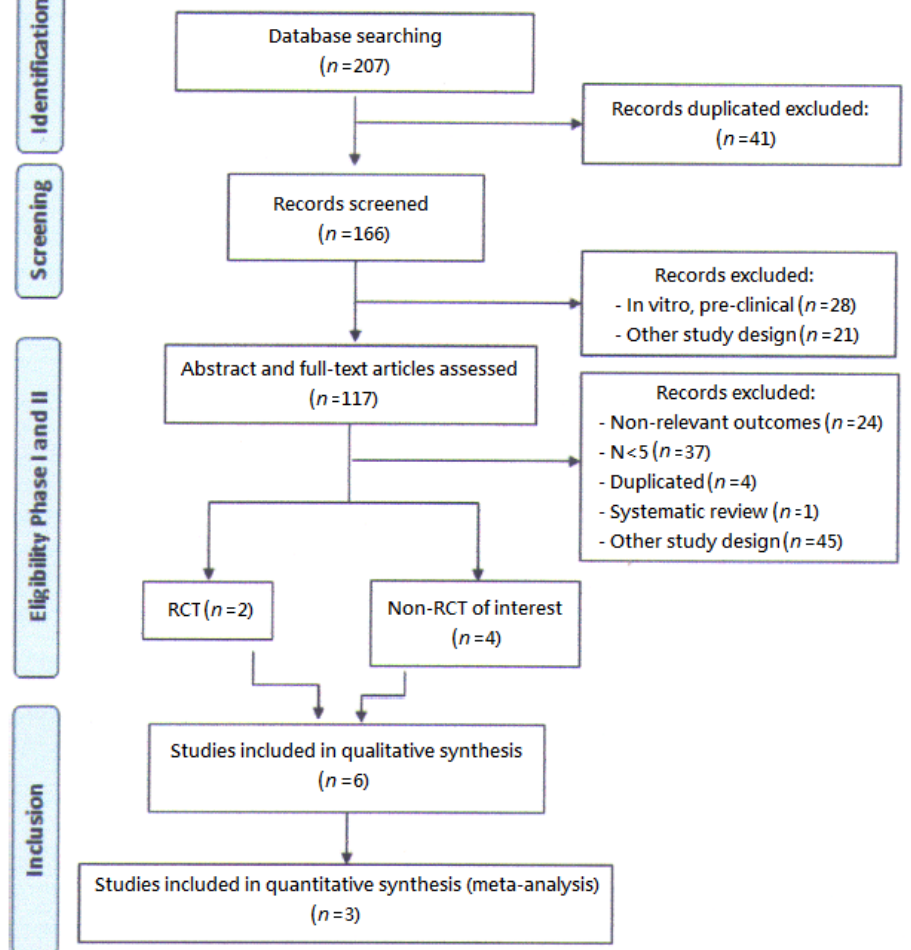
Figure 1. Elosulfase alfa for MPS IVA: A flowchart of a systematic review. Proportional